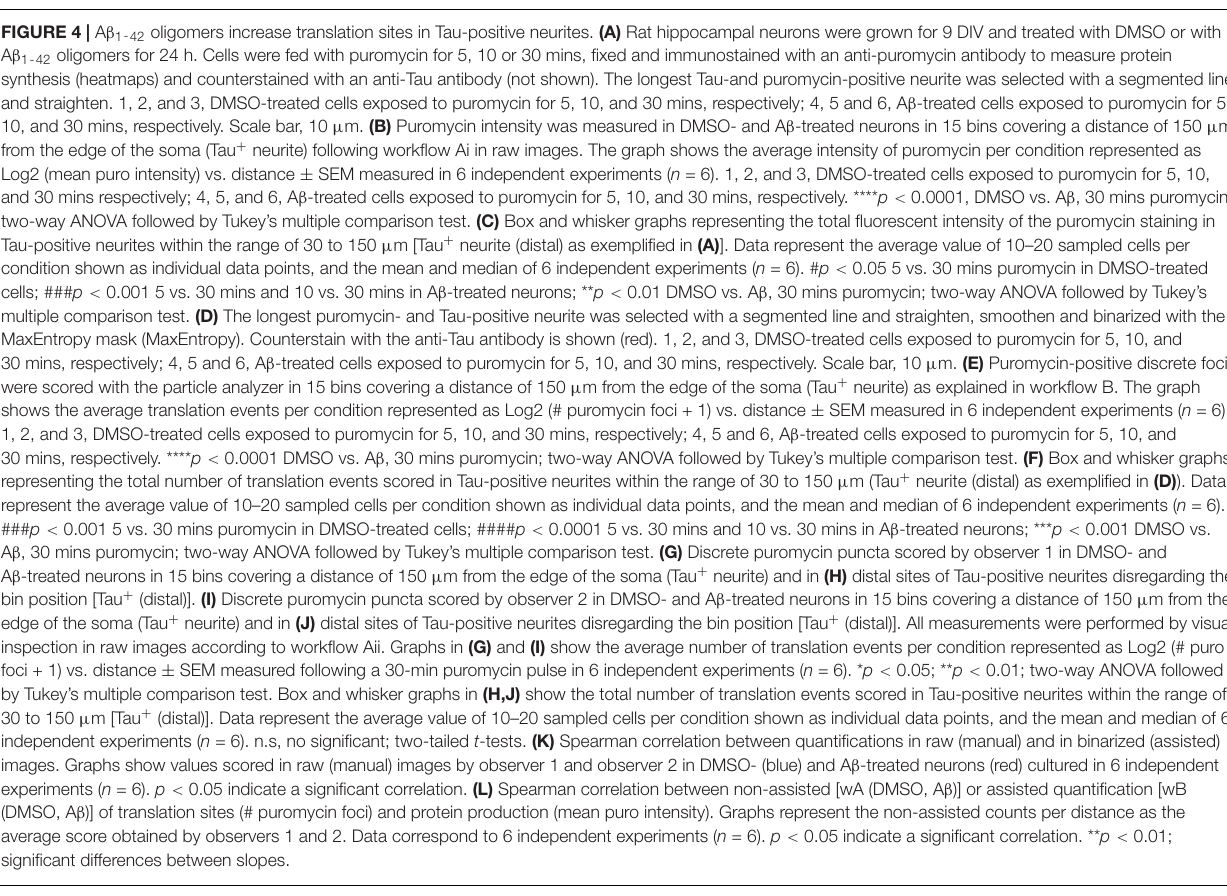
FIGURE 4 | A β 1 - 42 oligomers increase translation sites in Tau-positive neurites. (A) Rat hippocampal neurons were grown for 9 DIV and treated with DMSO or with A β 1 - 42 oligomers for 24 h. Cells were fed with puromycin for 5, 10 or 30 mins, fixed and immunostained with an anti-puromycin antibody to measure protein synthesis (heatmaps) and counterstained with an anti-Tau antibody (not shown). The longest Tau-and puromycin-positive neurite was selected with a segmented line and straighten. 1, 2, and 3, DMSO-treated cells exposed to puromycin for 5, 10, and 30 mins, respectively; 4, 5 and 6, A β -treated cells exposed to puromycin for 5, 10, and 30 mins, respectively. Scale bar, 10 µ m. (B) Puromycin intensity was measured in DMSO- and A β -treated neurons in 15 bins covering a distance of 150 µ